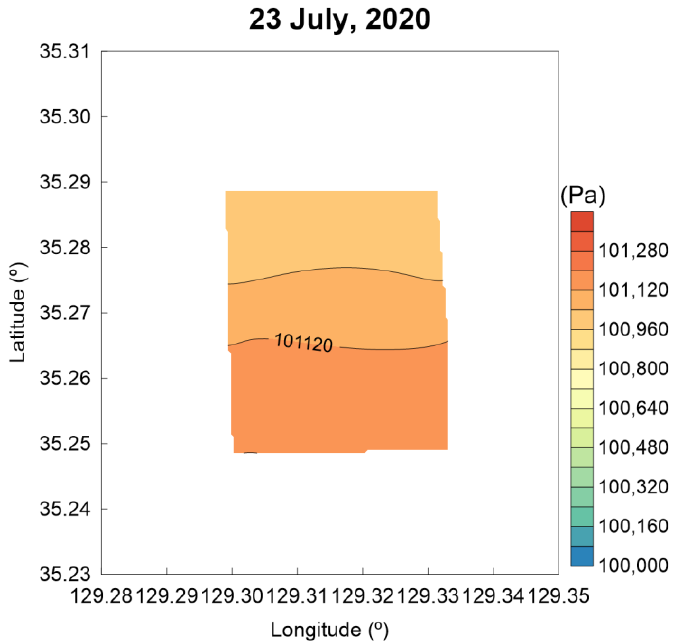
Figure 25. Distribution of atmospheric pressure in the Gijang coastal waters sea (23 July, 2020).